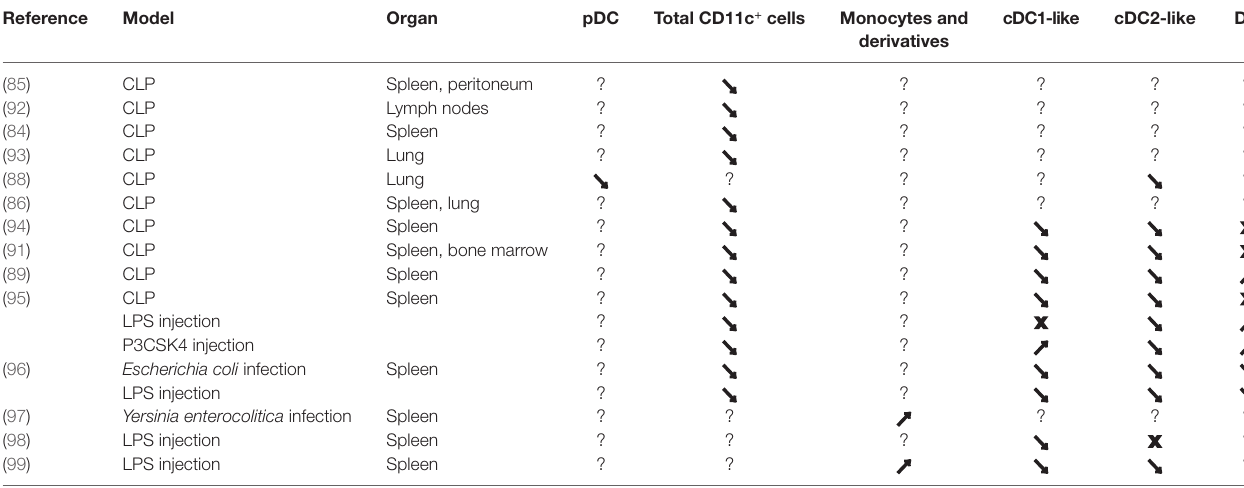
Down or up arrows mean that the cell number is decreased or increased compared to controls, respectively. The cross means that the cell number is not significantly changed compared to controls. Cell numbers described here were measured within 24 h after injection for endotoxemia models or within a week after infection or surgery for CLP